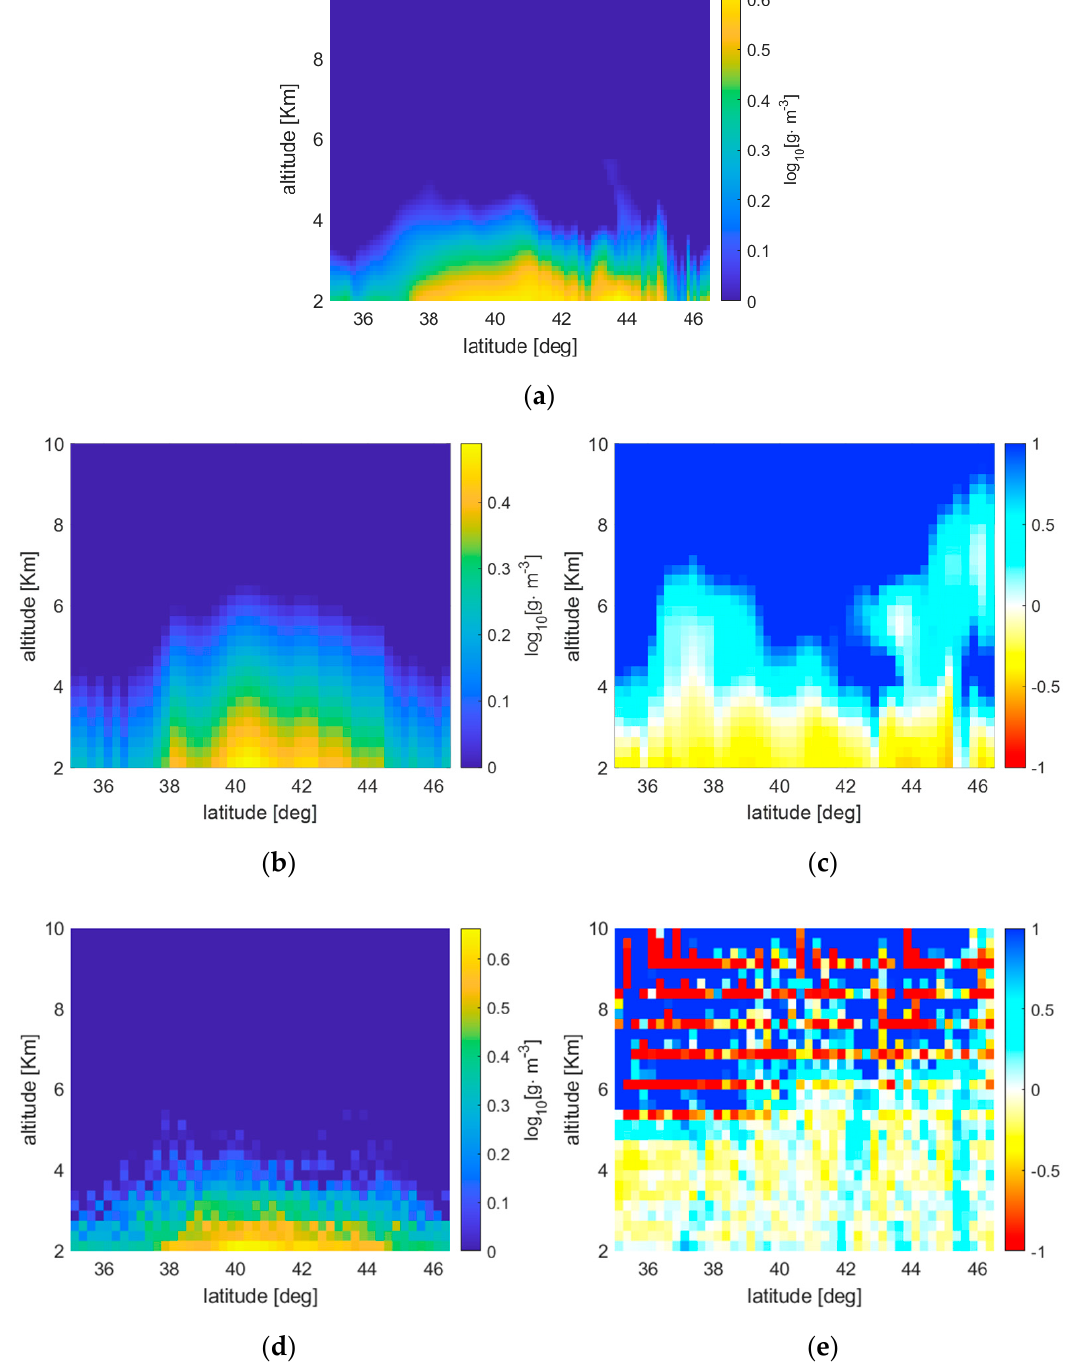
Figure 7. ( a ) True WV field (analysis of 27 July 2020 03:00 a.m.) as a function of angle and altitude; ( b ) retrieved WV field with ERTA and ( c ) the corresponding normalized error field; ( d ) retrieved WV field with LSATR and ( e ) the corresponding normalized error field defined as in Equation (17). Satellite configuration: 1Tx ‐ 10Rx.